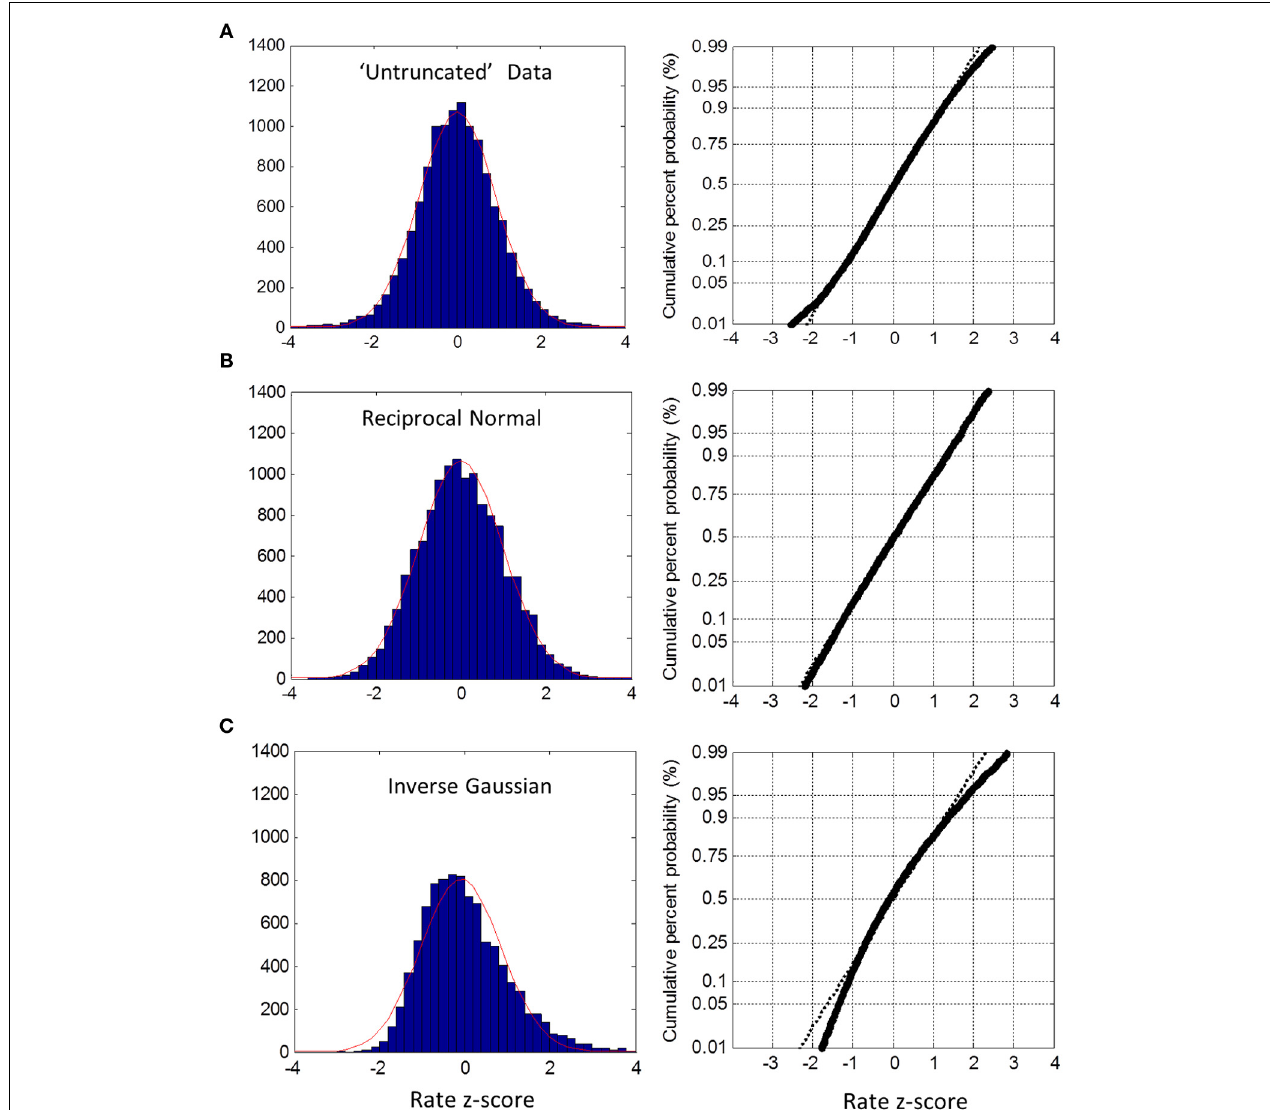
FIGURE 5 | Untruncated group rate histograms (left column) and rate probit plots (right column). (A) Empirical rate from “untruncated” blocks (c.v. < 0.4) showing near Normal distribution over 5–95% interval with slight deviation in the tails (B) Simulated